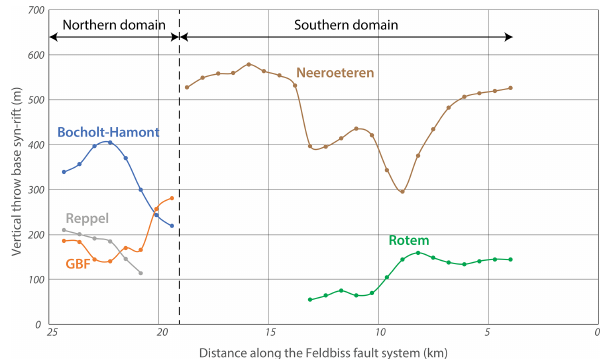
Figure 8. Cenozoic vertical throws along the major faults of the FFS based on the G3Dv3 model. This trace runs from the Belgian–Dutch border in the southeast towards the supposed bending of the GBF into the Overpelt fault in the northwest. Notice the abrupt change in the vertical throw of faults at the boundary between the northern and southern